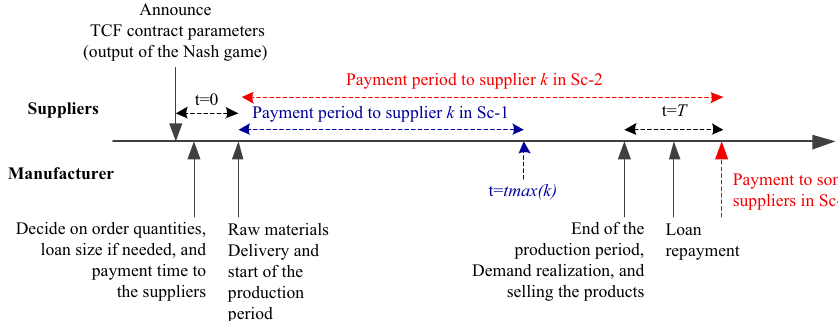
Fig. 1 The sequence of events for the proposed game in Sc-1 and